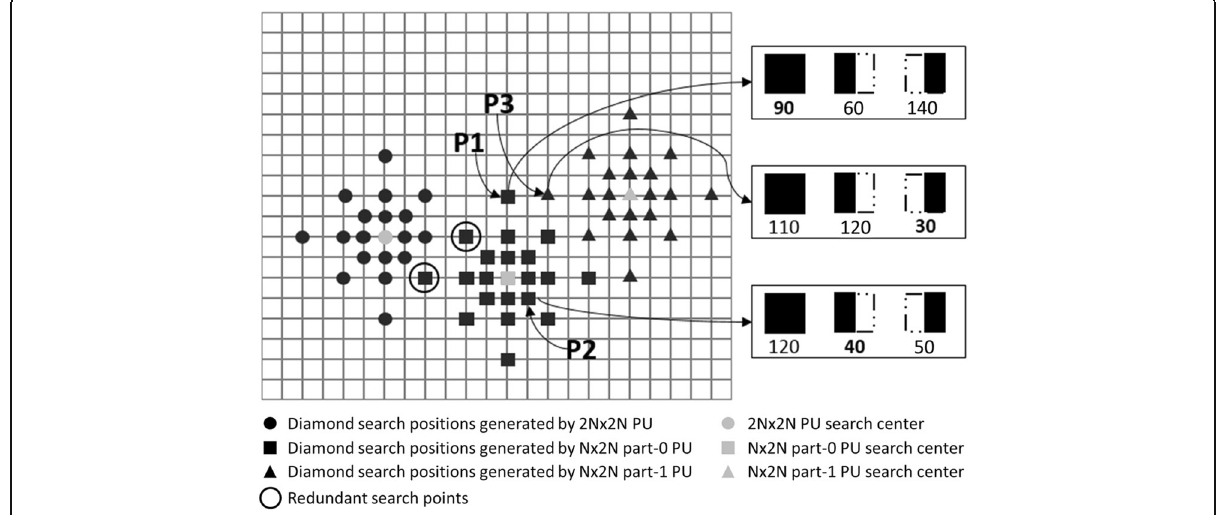
Fig. 4 The first diamond search of the concurrent TZ search